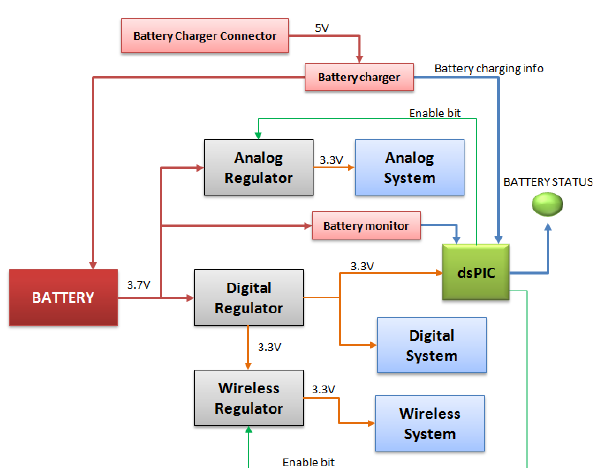
Figure 4. Power management block diagram.